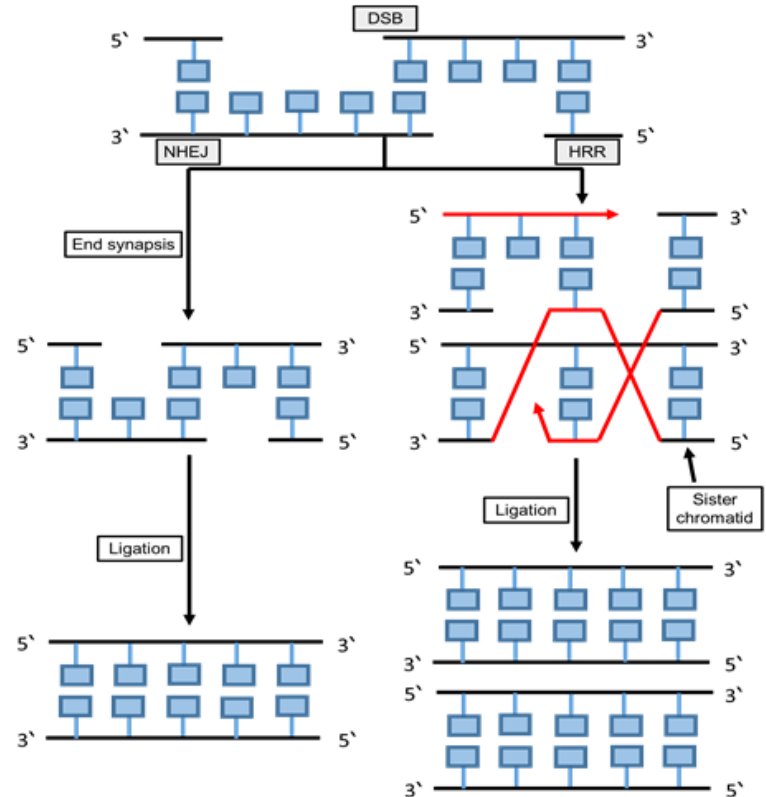
Figure 6. Non-homologous end joining and homologous recombination repair. The schematic diagram summarizes the main components and the mechanisms of the non-homologous end joining and homologous recombination repair pathways. In NHEJ the break ends are directly ligated without the need for a homologous template, as it typically utilizes short homologous DNA sequences called microhomologies to guide repair. In HRR, nucleotide sequences are replaced with two matching molecules of double-stranded or single-stranded nucleic acids, as this pathway requires a homologous sequence to guide repair.